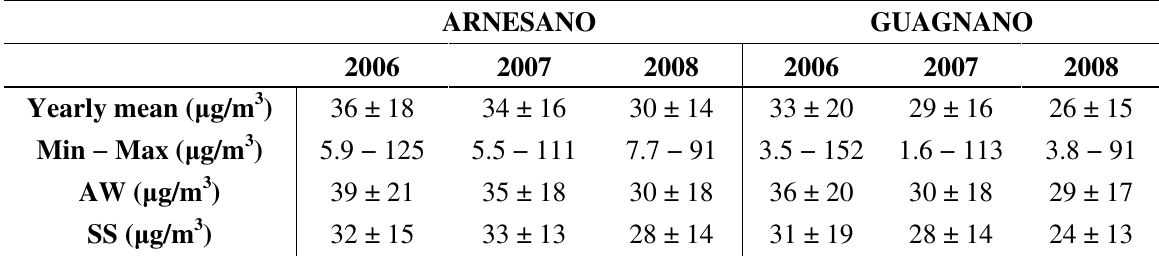
Table 1. Yearly means, minimum (Min), maximum (Max), autumn-winter (AW), and spring-summer (SS) mean values ± 1 SD deviation of PM10 mass concentrations at Arnesano and Guagnano from 2006 to